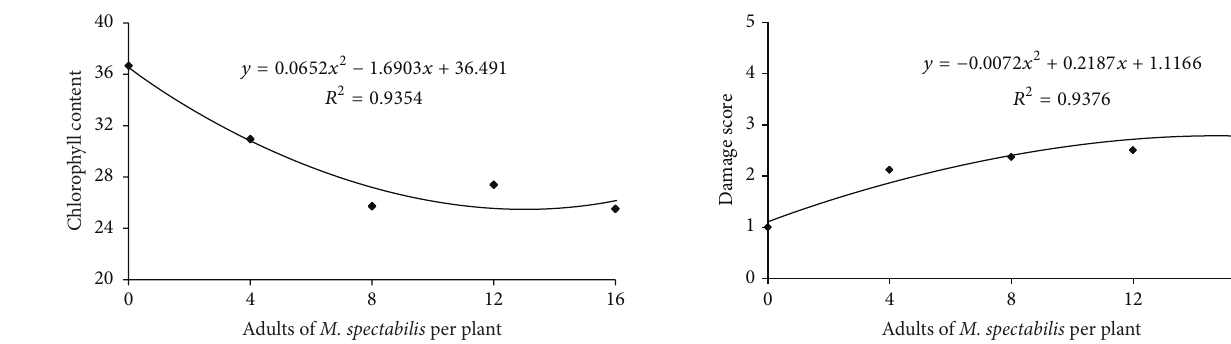
Figure 3: Relationship between infestation levels of M. spectabilis adults and damage scores for B. ruziziensis over 6 days.